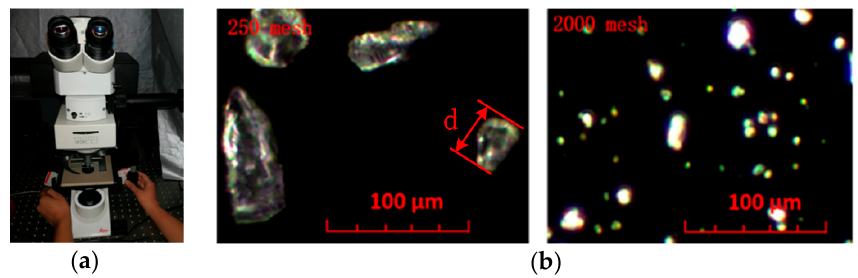
Figure 5. SiO 2 powder samples used in the tunnel test: ( a ) optical microscope; ( b ) 250 and 2000 mesh powder specimen enlargement. Table 3. Diameter situations of tested SiO 2 powder.